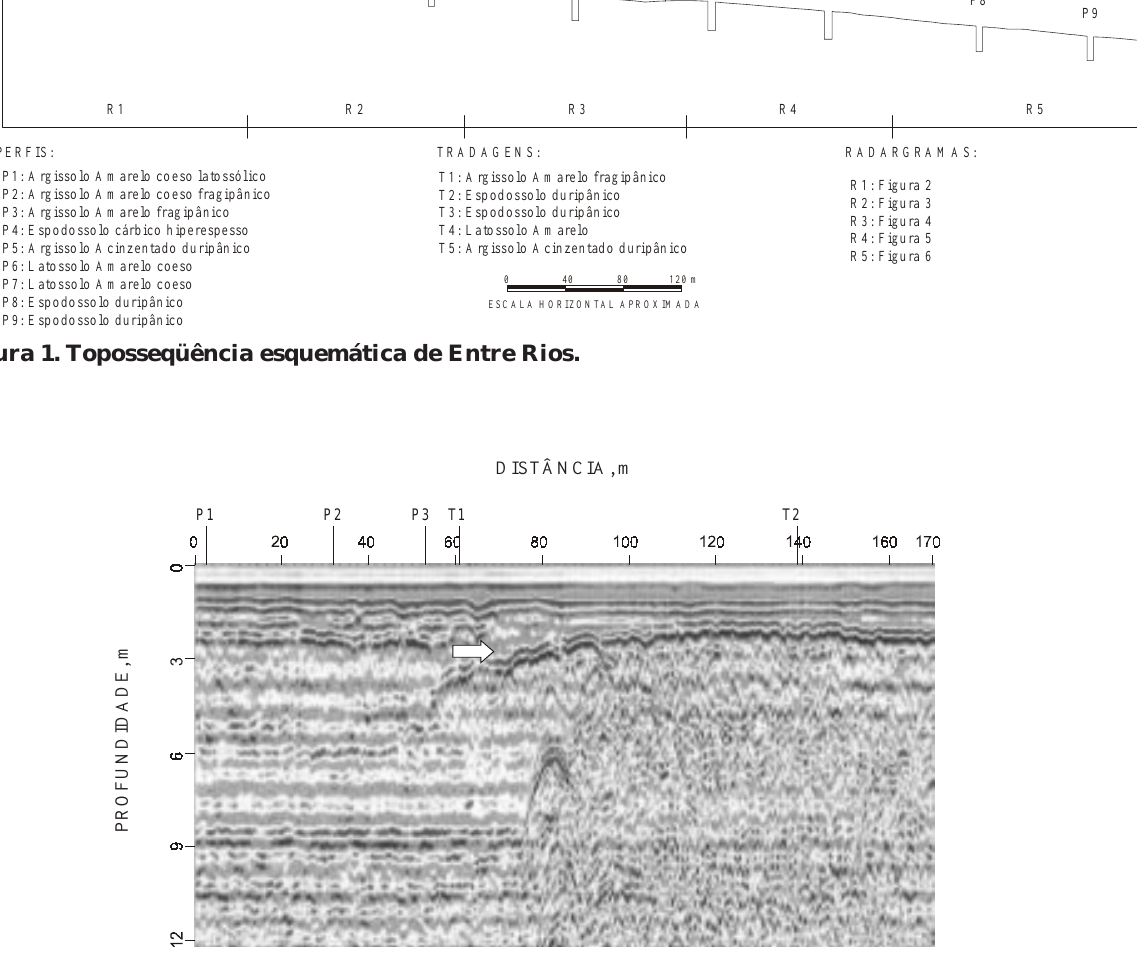
Figura 2. Radargrama - R1 mostrando Argissolo intergrade Latossolo entre a distância de 0-30 m e Argissolo Amarelo com fragipã entre 30-75 m. Após os 80 m, aparece o Espodossolo com duripã. A seta indica o início refletor forte (duripã). O perfil P2 está localizado em 32 m e o P3 em 53 m. As tradagens T1 e T2 estão localizadas em 61 e 139 m,